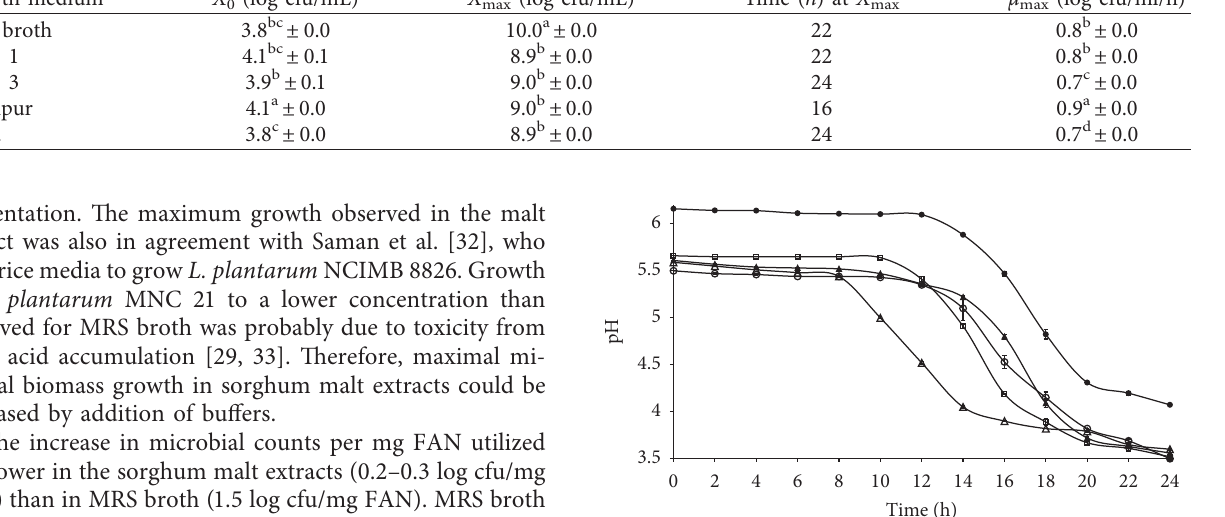
Figure 1: Growth profiles of L. plantarum MNC 21 in MRS broth and malt extracts from different sorghum varieties. Error bars show standard deviations of three independent Table 1: L. plantarum MNC 21 growth parameters in MRS broth and sorghum malt extracts. Growth medium